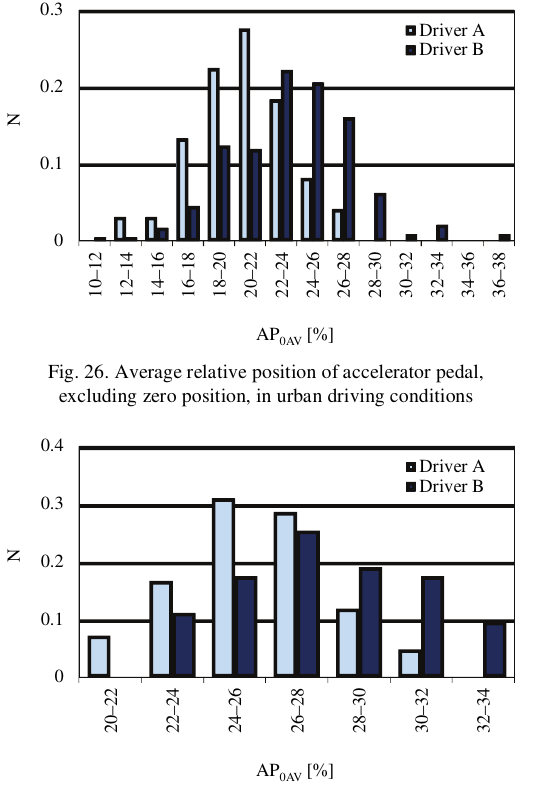
Fig. 27. Average relative position of accelerator pedal, excluding zero position, in extra-urban driving conditions